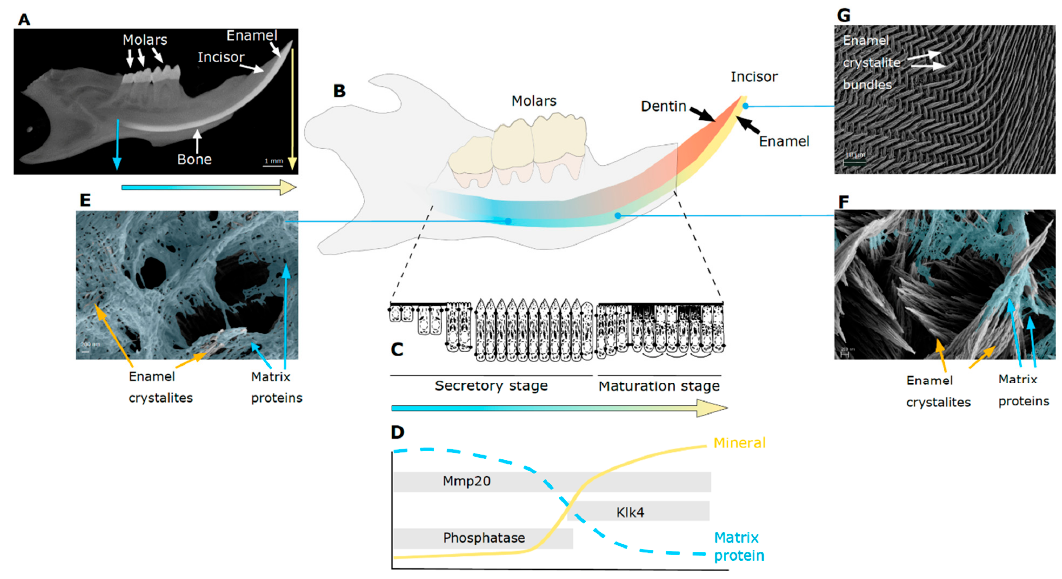
Figure 1. Illustration of the process of enamel formation. ( A ) Micro computed tomography radiograph of mouse mandible (without mandibular ramus) showing lighter grey values for higher mineral density, tooth enamel in white on molar crowns and in a gradient according to increasing mineralization in the continuously forming incisor. Data acquired on a Scanco Medical μ 40 instrument (Scanco, Brüttisellen, CH). ( B ) Schematic representation of mouse mandible showing continuous incisor growth from early stages of enamel formation with high amount of protein (blue) to mature, erupted enamel containing less than 1% by weight protein and more than 95 % by weight mineral (yellow). ( C ) Schematic of ameloblast morphology indicating differentiation and different stages during enamel formation (adapted from Hu et al. [11]). Color filled arrow indicates progression of time and compositional changes of the mineralizing matrix from high protein content (blue) with little mineral, to low protein and high mineral content (yellow) in later stages of mineralization and mature enamel. ( D ) Graph depicting decreasing protein and increasing mineral content in developing enamel, with activity period of matrix metalloproteinase 20 (Mmp20), phosphatase and kallikrein-4 (Klk4) during mineralization of rodent incisors (adapted from Robinson et al. [12]). ( E – G ) Scanning electron microscopy (SEM) images of the forming mouse incisor in longitudinal plane. Enamel with high protein content seen at high magnification in late secretory stage ( E , scale bar 200 nm) and with some matrix protein, colored in blue, around crystal bundles in early maturation stage ( F , scale bar 200 nm). At lower magnification, the decussation pattern of crystal bundles in mature, erupted enamel in ( G , scale bar 10 microns). SEM—samples were fixed, dehydrated, epoxy resin embedded, polished, phosphoric acid etched, gold coated and imaged on a Zeiss SEM Ultra55.